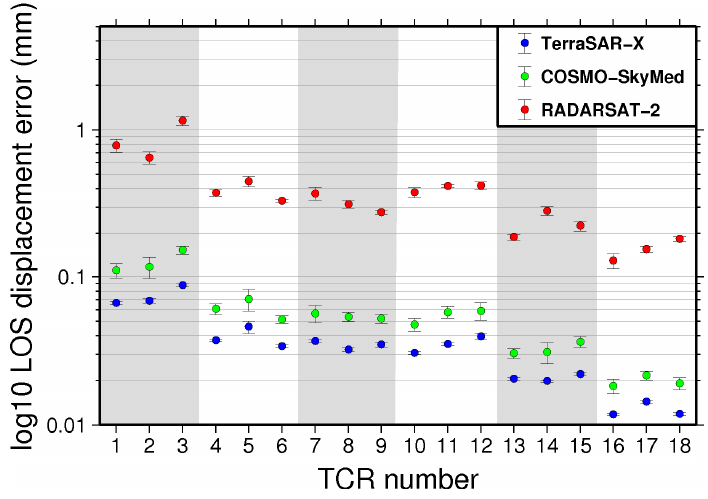
Figure 12. LOS displacement error derived from the SCR measurement for each TCR at Gunning. Each error estimate is derived by averaging the values measured in the five TSX images, four CSK images and three RSAT-2 images highlighted in Figure 8 that correspond to relatively stable clutter characteristics. Error bars are the 2-sigma standard errors of these observations. Background grey polygons are plotted to aid delineation of the different type groups of TCR design described in Table 2. The magnitude of the 2-sigma standard errors on the LOS displacement error estimates are plotted against TCR size in Figure 13. There is a clear relationship between TCR size and variability of displacement error (and implicitly SCR) with a consistent exponential trend between sensors. This confirms the theoretical phase noise behaviour demonstrated previously in the PS phase simulation (Figure 2) whereby the phase noise becomes less variable as the SCR increases in concert with an increase in target size.